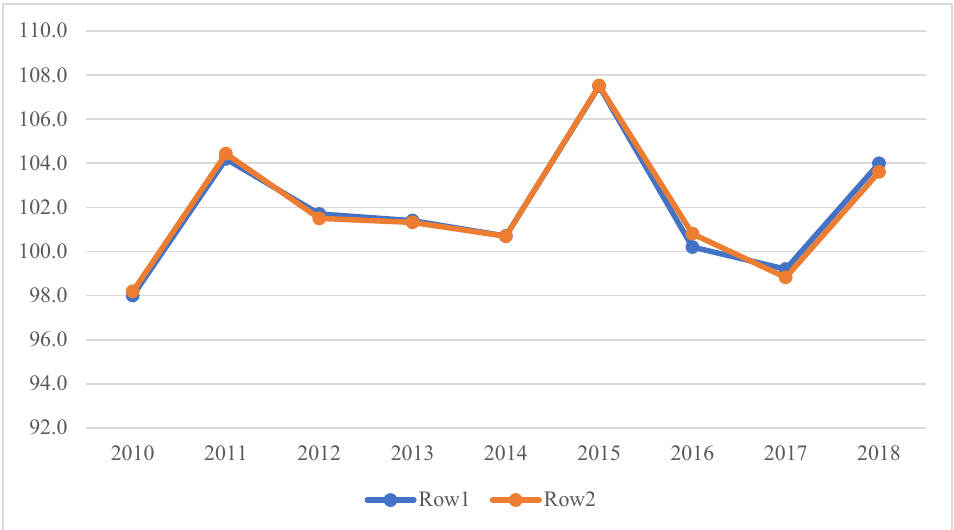
Figure 2. Geometric interpretation of multifactorial model (13) for the 2010–2018 data. Row 1 corresponds to the original data, row 2—to the constructed model.